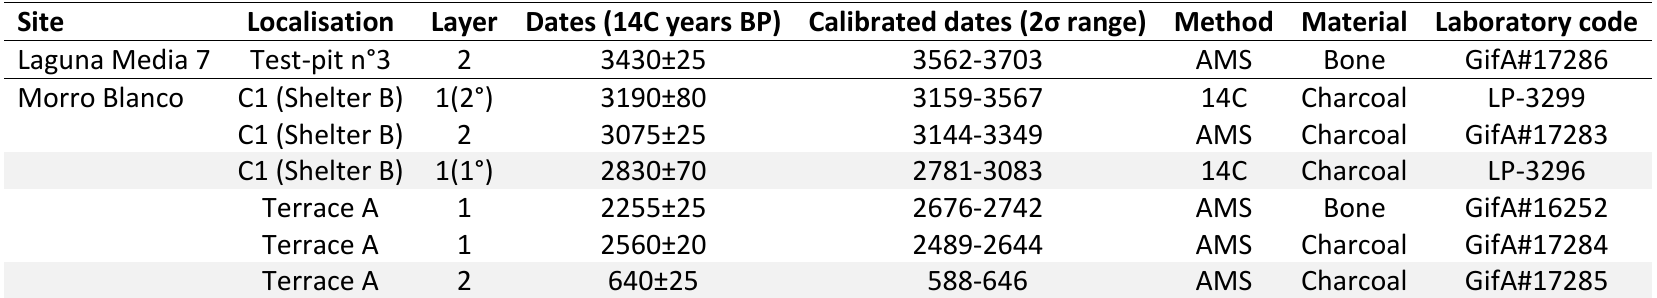
Table 2. Radiocarbon dating from both sites (Morro Blanco dates taken from Yacobaccio et al. 2018)